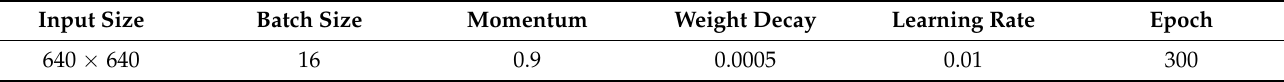
Table 3. The initialization training